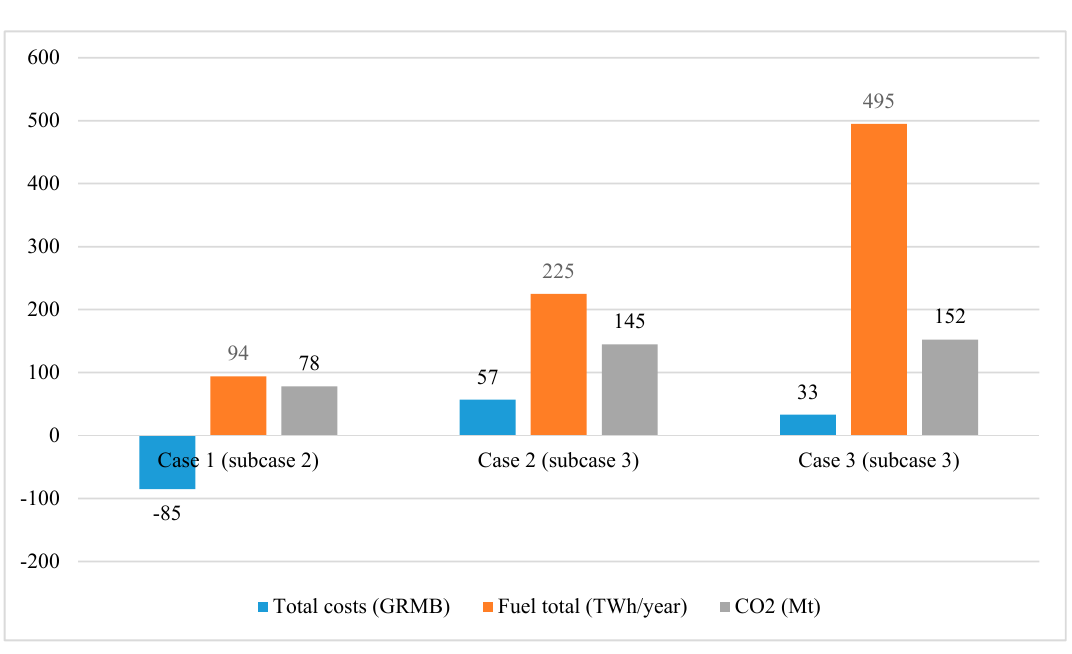
Figure 12. Comparisons of annual savings, fuel consumption and CO 2 emissions of best subcases among all three cases.